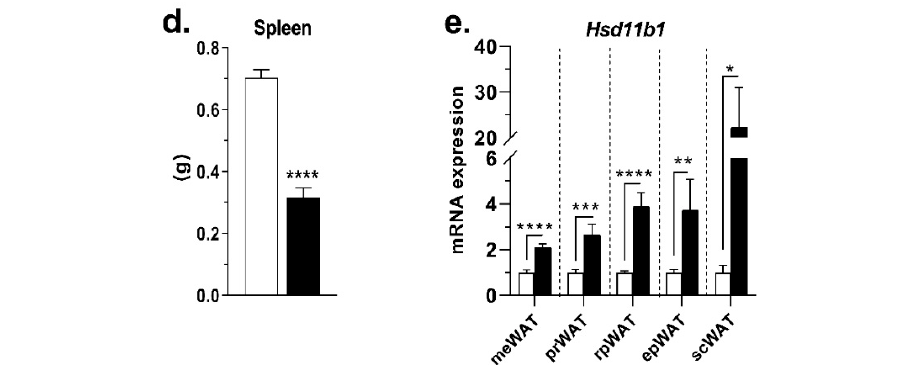
Figure 1. Glucocorticoid continuous administration promoted inhibition of the HPA axis. ( a ) Serum corticosterone, ( b ) adrenal gland mass, and ( c ) histological sections; ( d ) spleen mass, and ( e ) Hsd11b1 gene expression in mesenteric—meWAT, perirenal—prWAT, retroperitoneal—rpWAT, epididymal—epWAT, and subcutaneous inguinal—scWAT of control (CT), and glucocorticoid-treated rats (GC). Data are mean ± SEM of 13 (CT) and 17 (GC) rats ( a , b , d ), and 7–12 (CT) 11-12 (GC) samples ( e ). * p < 0.05; ** p < 0.01; *** p < 0.001 and **** p < 0.0001 vs. CT (Unpaired Student t -test; Mann–Whitney test in a and d ). ( c ) HE staining—100 × and 400 × magnification. G: Glomerulosa zone; F: Fasciculata zone; R: Reticularis zone, and M: Medulla.